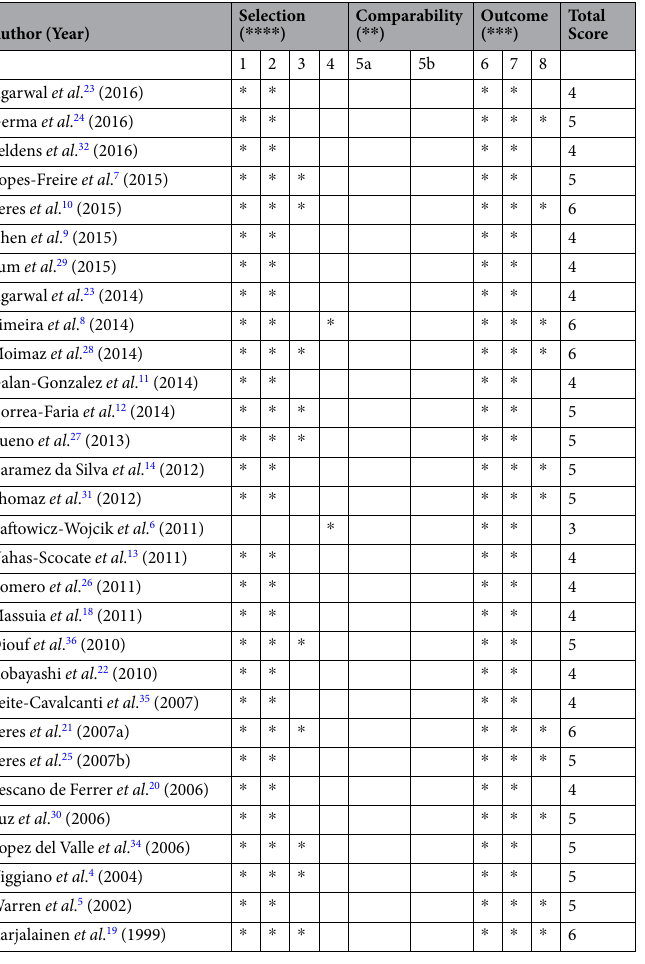
Table 3. Quality of the studies on the Newcastle-Ottawa Quality Assessment Scale for cohort studies. Criteria: (1) Representativeness of the exposed cohort. (2) Selection of the non-exposed cohort. (3) Ascertainment of exposure. (4) Demonstration that outcome of interest was not present at start of study. (5) Comparability of cohorts on the basis of the design or analysis, (5a) for one factor and (5b) for additional factor. (6) Assessment of